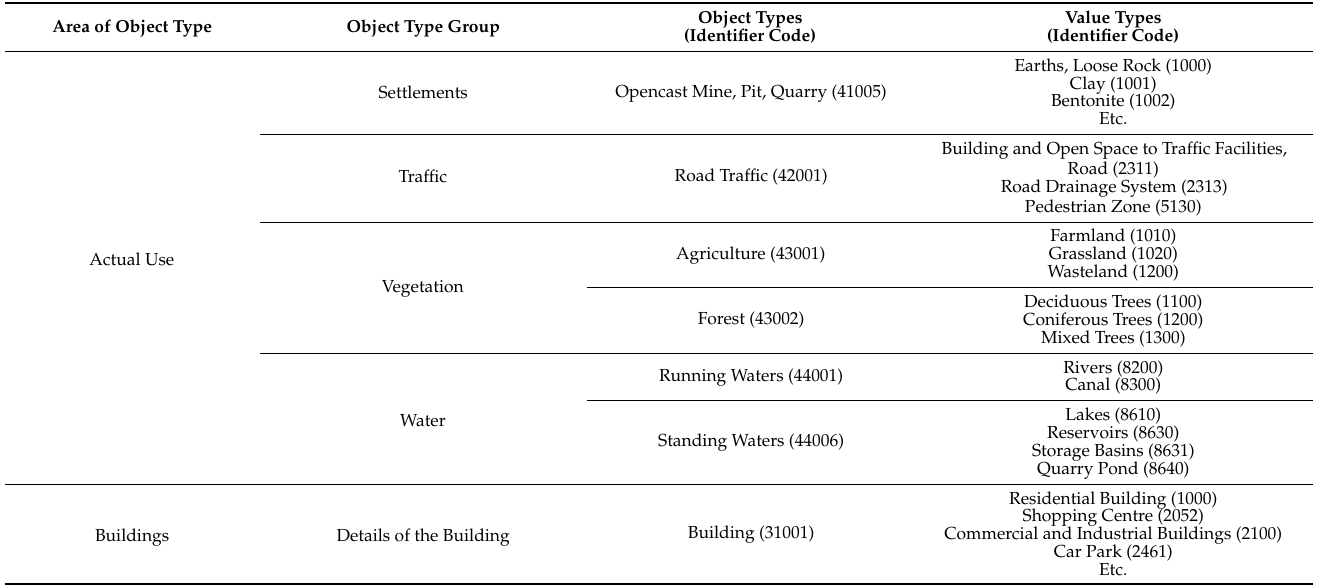
Table 1. An illustrative example of the ALKIS data model structure based on specific data used in this work that is categorized into object types, value types and corresponding Identifier Codes. The object types “opencast mine, pit, quarry (41005)” and “building (31001)” were solely considered on the object level. To provide an impression of the value types within these two object types, we have only listed individual value types due to the available quantity. This listing is intended to illustrate the complexity of the data model. A complete documentation of the ALKIS data model structure is provided by the AdV